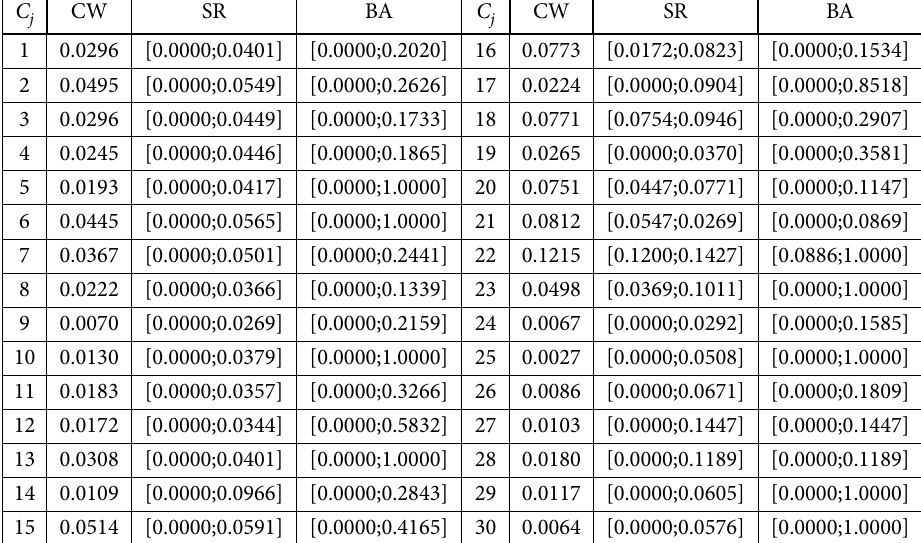
Table 10. Results of the sensitivity analysis based on the TOPSIS method for GDM after using the ag- gregation operator